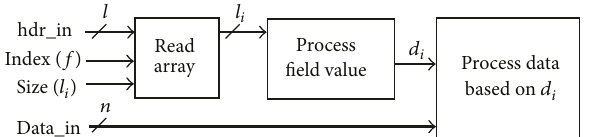
Figure 13: Realization of an example of protocol-sensitive subsystem using HLS.